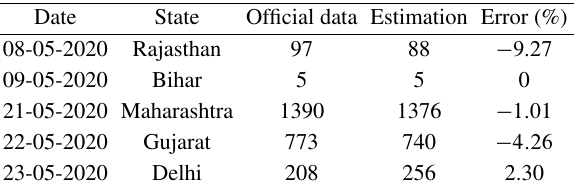
Table 7 Comparison of total reported and estimated death cases.